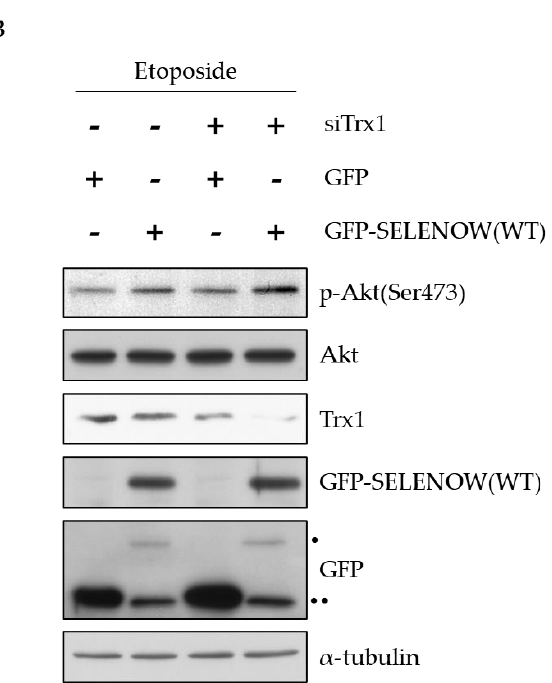
Figure 5. Decreased Akt phosphorylation of Trx1-deficent cells is restored by SELENOW. ( A ) MCF7 cells were transfected with siTrx1 or His-SELENOW(U13C), or co-transfected with siTrx1 and His-SELENOW(U13C) for 24 h and then treated with etoposide (25 µ M) for 10 h. The cells lysates were analyzed by immunoblotting with the indicated antibodies. ( B ) MCF7 cells were co-transfected with siTrx1 and GFP-SELENOW(WT) for 24 h and further treated with etoposide for 10 h. The cells lysates were analyzed by immunoblotting with the indicated antibodies. • Full length GFP-SELENOW, •• pre-terminated GFP-SELENOW.